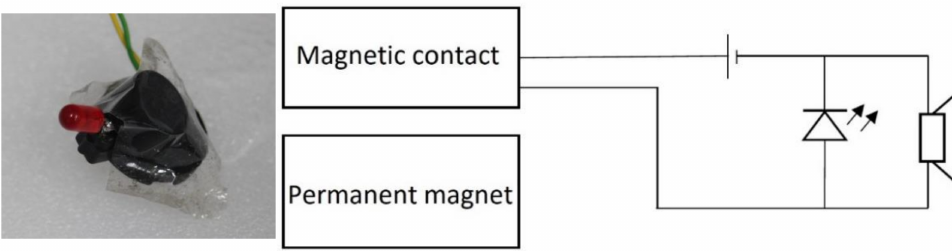
Figure 4. Indication device (right) and its wiring